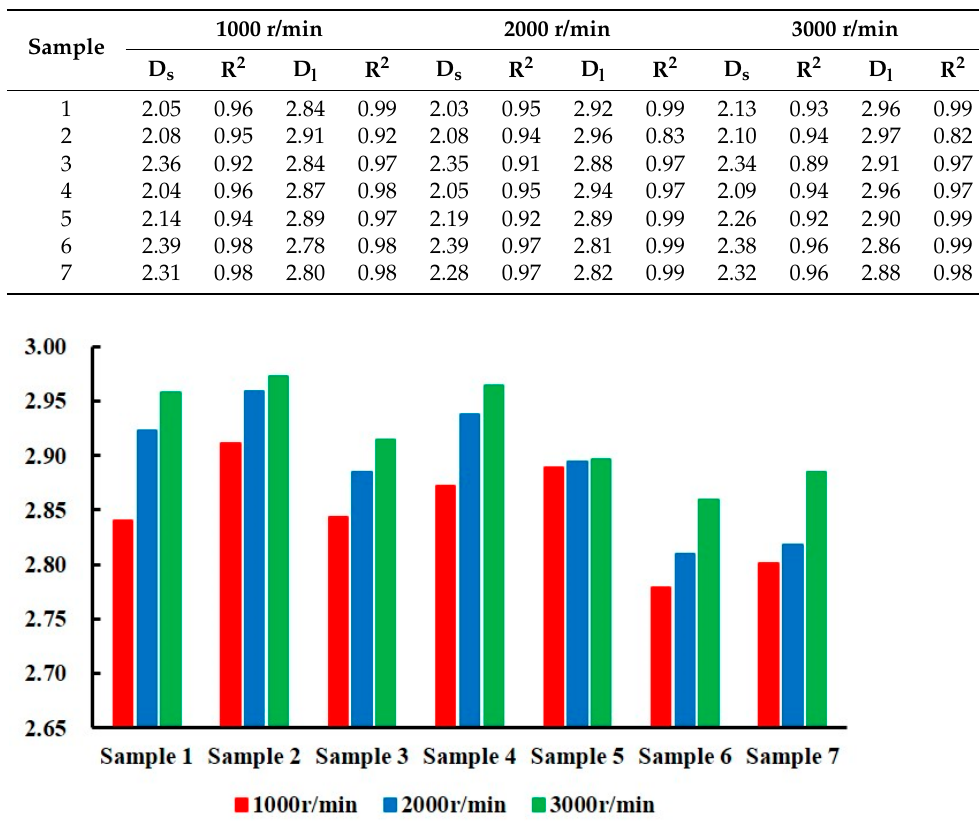
Figure 11. Trends of D s in different centrifugal speeds. The T 2cutoff value was used to divide the moveable fluid and the bound fluid in the NMR curve. However, in Figure 9, it is visible that some pores with T 2 values larger than the T 2cutoff were still resided by fluid. Based on the difference values between the NMR curves of water-saturated and centrifuged samples, real pore size distribution and content of the dynamic variation in centrifugation can be reflected. According to Equation (14), the curves of the difference between T 2 spectrums in different centrifugation speeds could be used to calculate the fractal dimensions of the fluid variation (Figure 12), which in- cludes the fractal dimensions of fluid variation between water saturated and 1000 r/min (D 1 ), 1000 r/min and 2000 r/min (D 2 ), 2000 r/min and 3000 r/min (D 3 ). Table 6 shows the fractal analysis results of the fluid variation between different centrifugation speeds, and most of the samples showed that with the increase of centrifugal speed, the fractal dimen- sions of fluid variation became larger (Figure 13). It was indicated that in the process of centrifugation, the water residing in the pores with simple structures was removed pref- erentially, and with the increase of centrifugal speed, the water reserved in the pores with